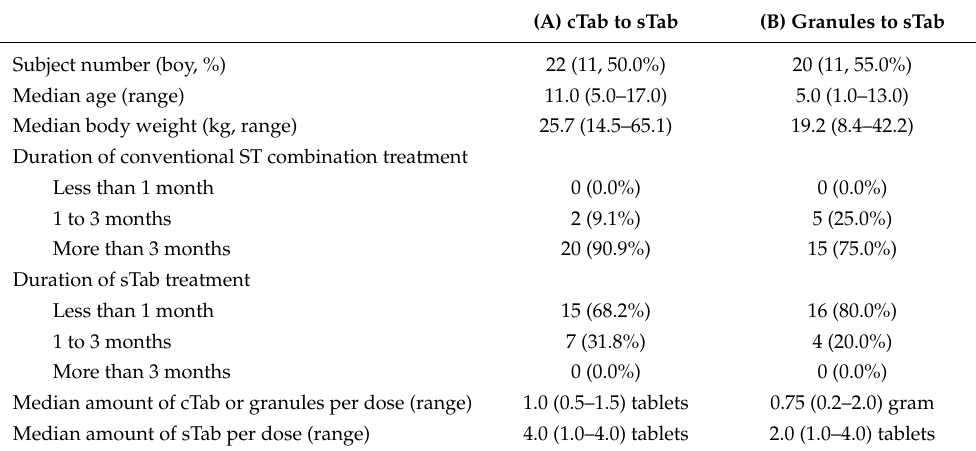
Table 2. Patients’